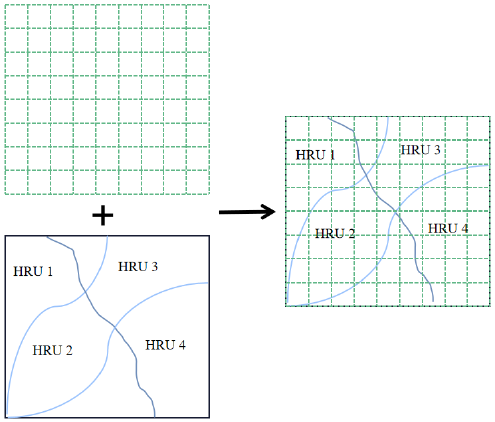
Figure 2. Integration of Soil and Water Assessment Tool (SWAT) and MODFLOW computing units.